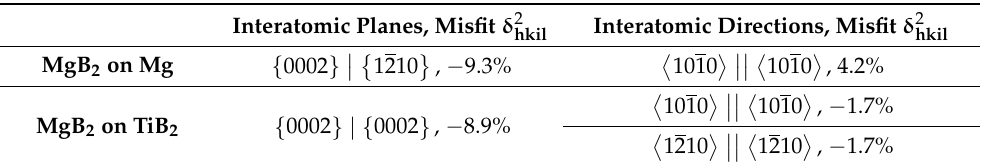
Table 1. Orientation relationship between MgB 2 and Mg or TiB 2 , and their corresponding atomic misfits [19].